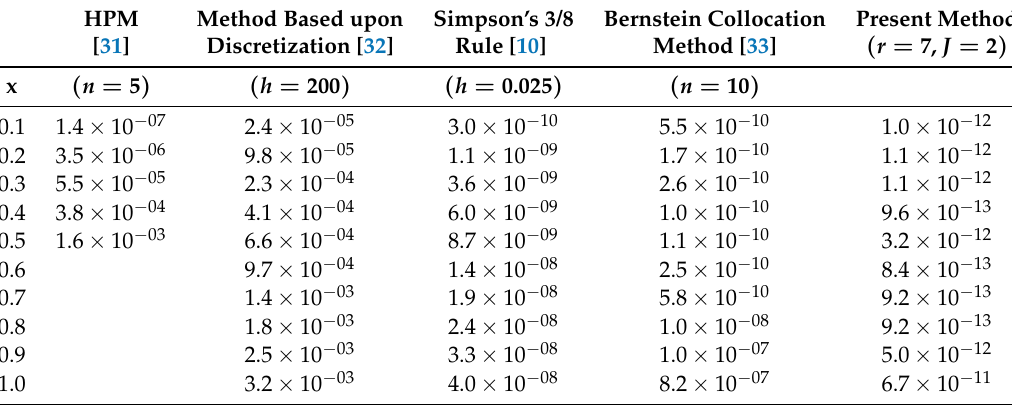
Table 3. The comparison between absolute errors of Example 3 for u 1